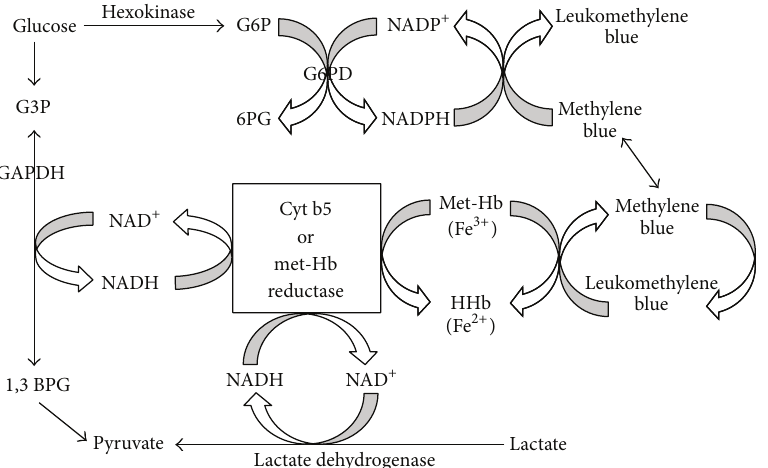
Figure 1: Biochemical pathways of hemoglobin reduction. NAD Nicotine adenine dinucleotide, GAPDH: glyceraldehyde-3-phosphate dehydrogenase, G3P: glyceraldehyde-3-phosphate, 1,3 BPG: 1,3 bisphosphoglycerate, cyt: cytochrome, and metHB: methemoglobin. Adapted from